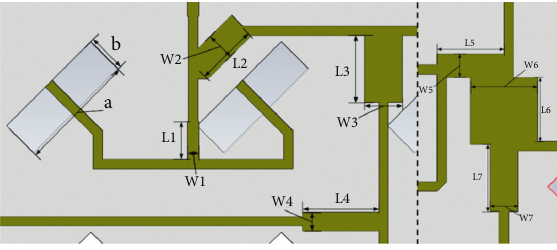
Figure 13: Dimension drawing of the proposed antenna. Table 1: Design parameters of the proposed antenna. Parameter